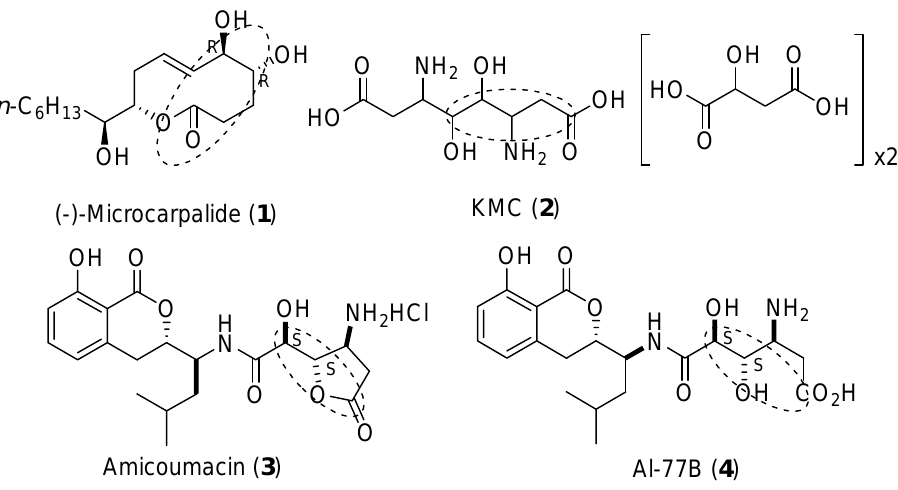
Figure 1. (4,5)-Dihydroxycarboxylate